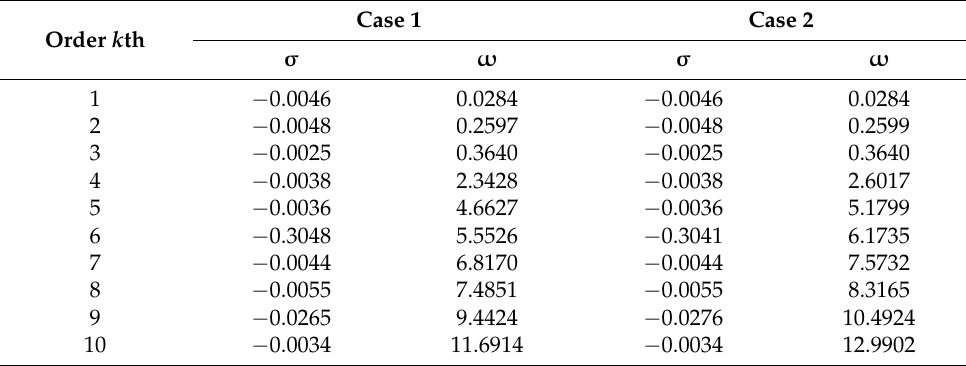
Figure 9. Pressure fluctuations in the draft tube. Table 5. Complex frequencies of the hydropower